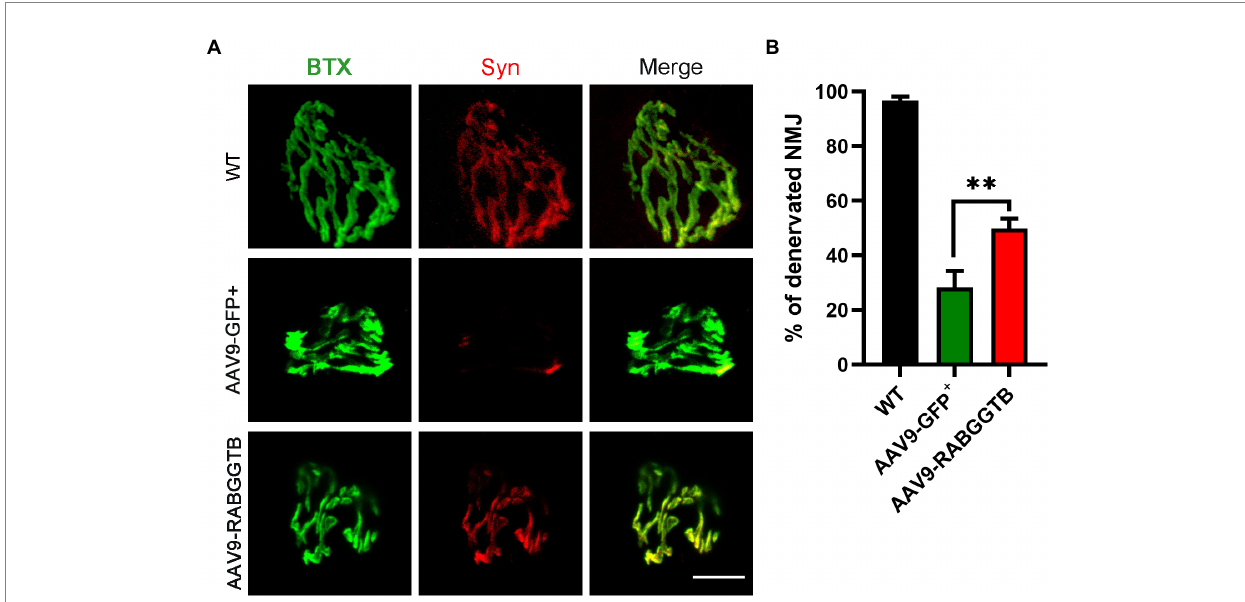
FIGURE 5 Overexpression of RabGGTB rescues neuromuscular junctions of the gastrocnemius muscle in SOD1 G93A mice. (A) Immunofluorescence staining the NMJ of the gastrocnemius muscle in P120 SOD1 G93A mice labeled with α -cyclopentotoxin (red) and synaptophysin-positive presynaptic endings (green; scale bars, 5 μ M). (B) Quantification of the percentage of total innervated NMJ in the gastrocnemius muscle of mice at P120. The gastrocnemius section was 15 μ M deep, and each section counted three fields of view with total of 60 α -bungarotoxin staining endplates. According to the co-staining with the Syn marker, endplates were identified as denervated or not. Data represent the mean ± SEM, n = 3 mice per group; p -values were determined using t -tests. Error bars denote the SEM. * p <0.05, ** p <0.01, *** p <0.001. NMJ: neuromuscular